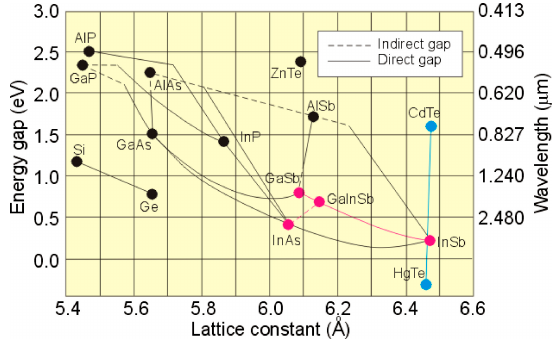
Figure 1. Band gap as a function of lattice constant for III–V compounds and their ternary and quaternary alloys. Reproduced with permission from [11], copyright AIP Publishing LLC (2009).